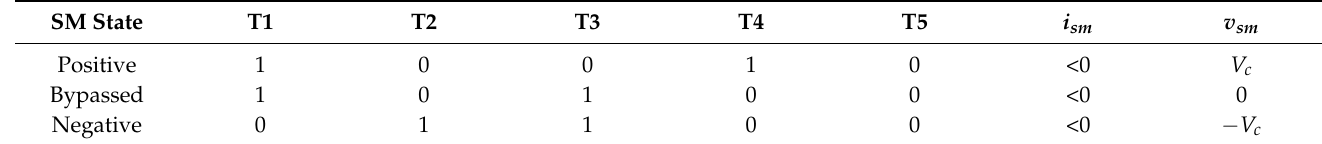
Table 6. CDSM STATCOM Mode Switching States.